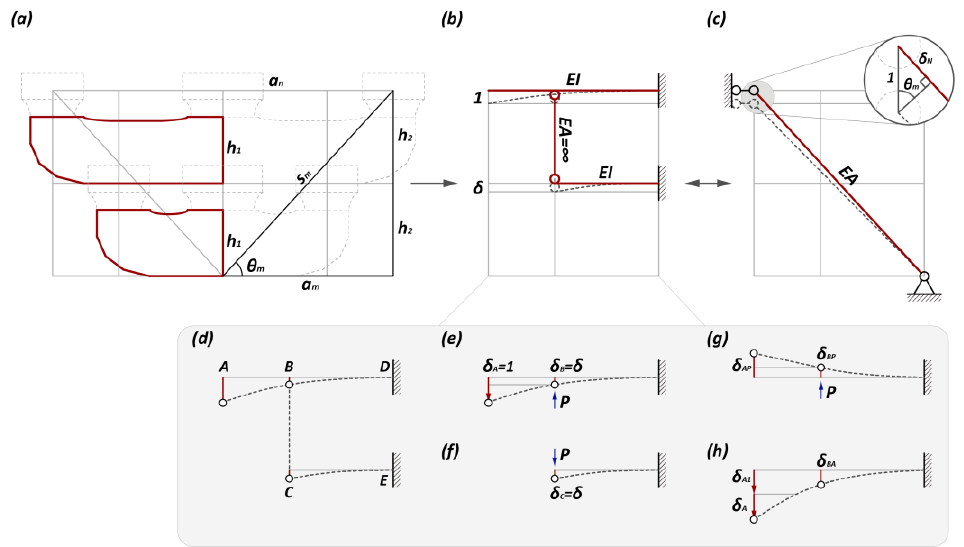
Figure 13. Calculation flow of the sectional reduction factor for the Chong-gong: ( a ) dimension of the Chong-gong; ( b ) diagram of the beam model of the Chong-gong; ( c ) vertical stiffness of the equivalent truss element; ( d ) deformation of the beam model; ( e ) force diagram for the upper beam; (f) force diagram of bottom beam; ( g ) deformation of the upper beam subject to force P; ( h ) deformation of the upper beam subject to concentrate load at the end.